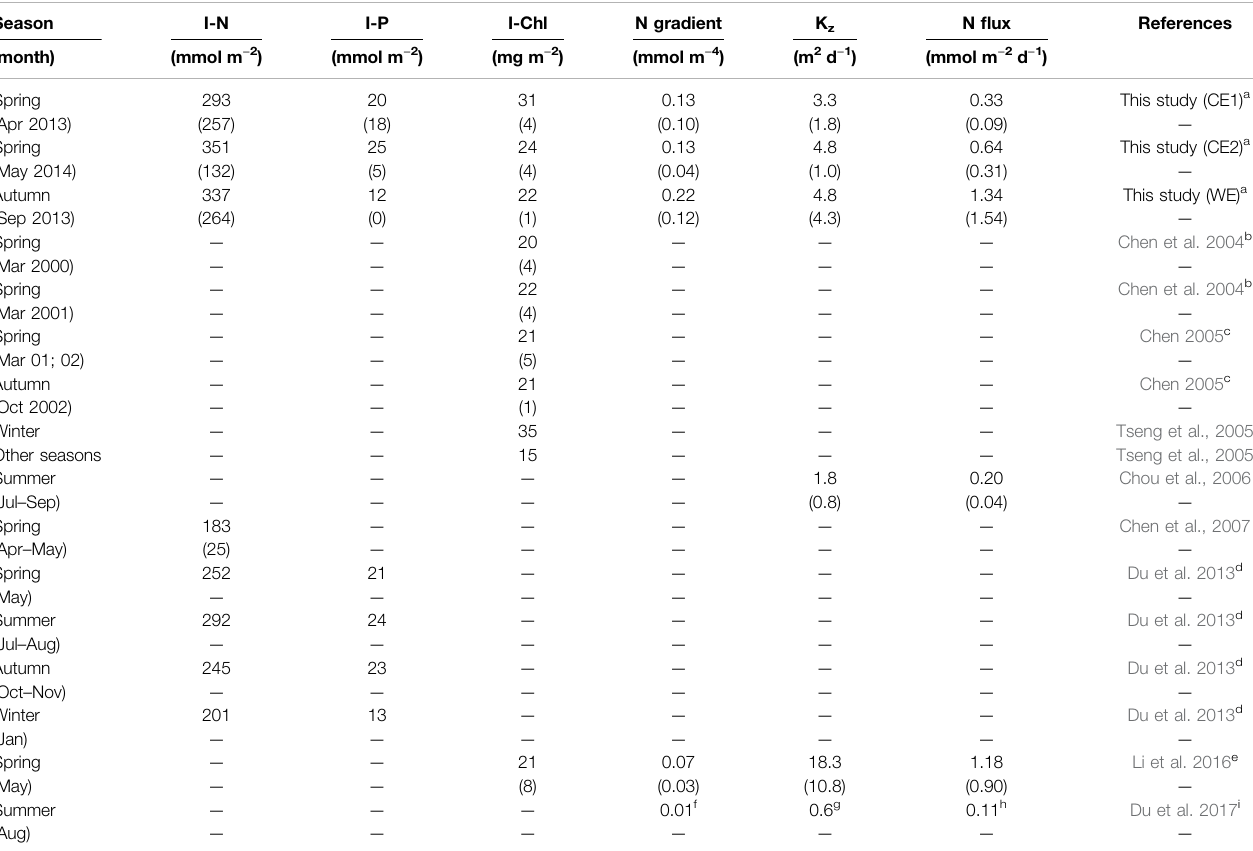
TABLE 3 | Compilation of published fi eld data on N, P and Chl inventories, N gradients, vertical diffusion coef fi cients and N fl uxes in the upper 100 m of the water column at different locations of the NSCS. Numbers in parentheses represent one standard deviation.